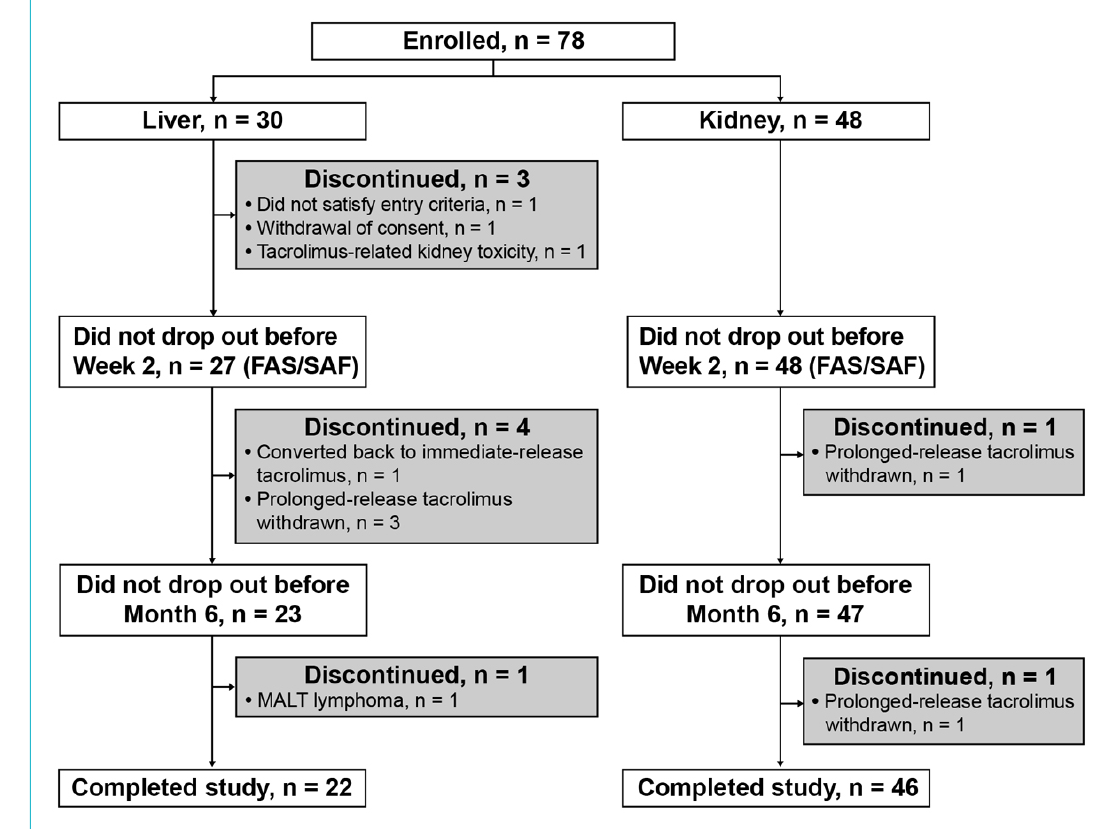
Figure 1: Flow of patients through study, stratified by organ transplanted. FAS = full analysis set; MALT = mucosa-associated lymphoid tissue; SAF = safety analysis